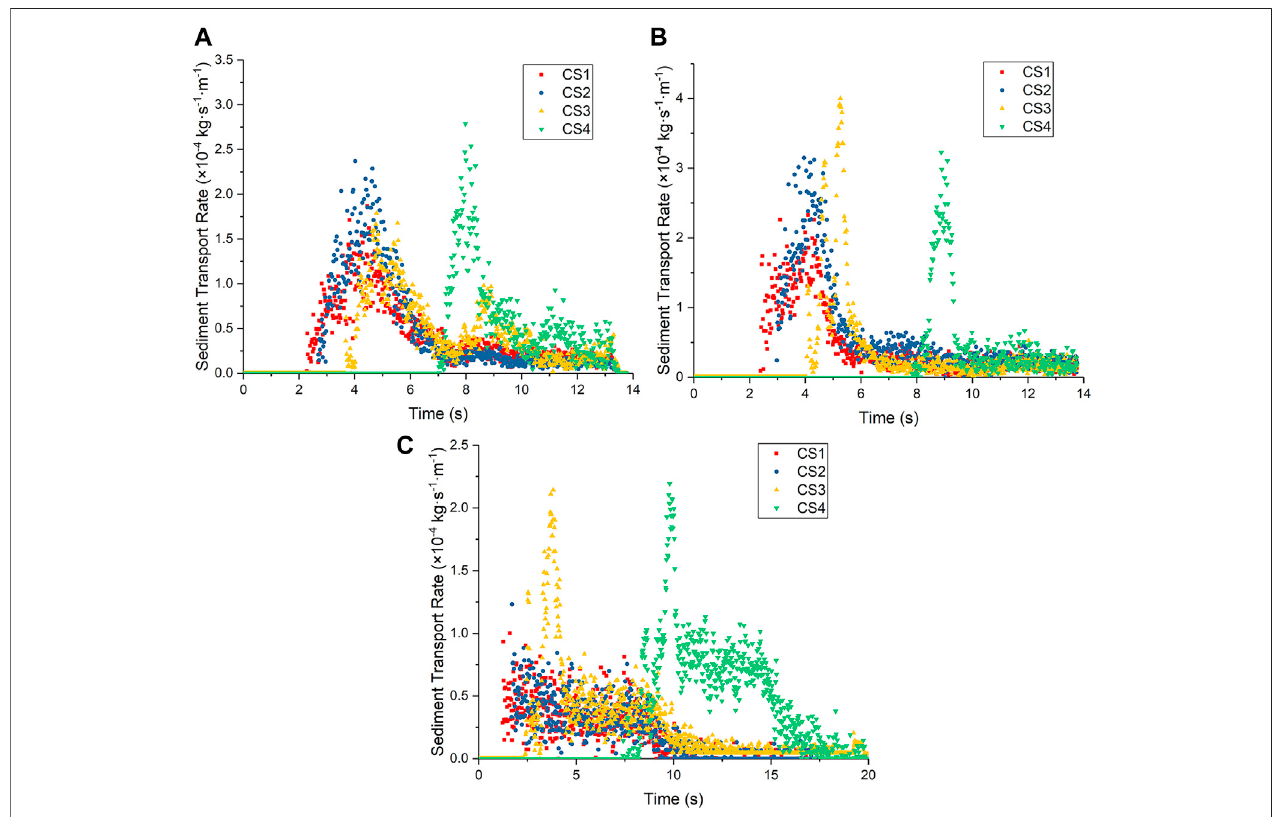
FIGURE 7 | Sediment transport, water erosion: (A) slope degree: 5 ° ; (B) slope degree: 15 ° ; (C) slope degree: 30 ° .